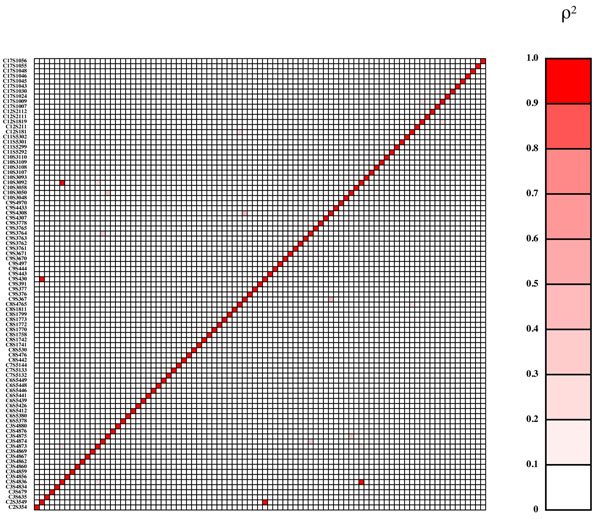
Gametic disequilibrium (r2) between functional variants for Q2. Markers are shown in chromosomal order from bottom to top and from left to right and are symmetric across the diagonal.